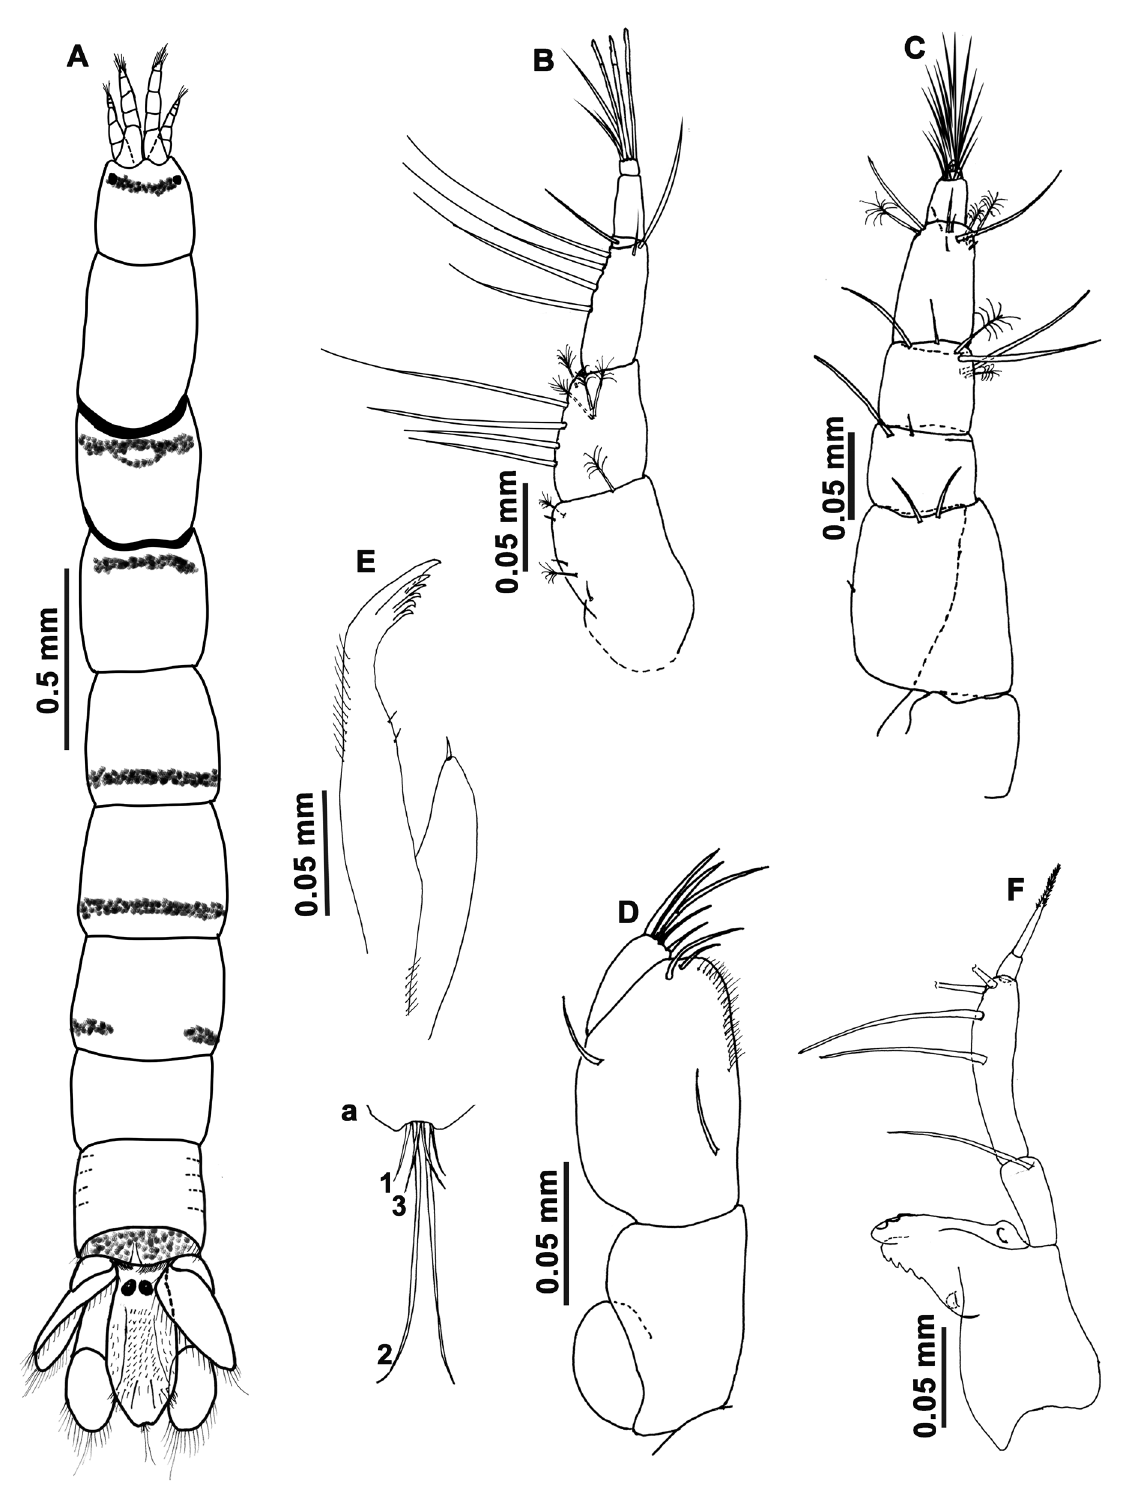
Fig. 17. Tinggianthura mexicana sp. nov., holotype, ♀, 3.7 mm, Oaxaca, Huatulco, El Maguey Bay (UMAR-PERA 561). A . Habitus and detail of the telson (a) (the numbers indicate the pairs of setae). B . Antennule. C . Antenna. D . Maxilliped. E . Maxilla. F .